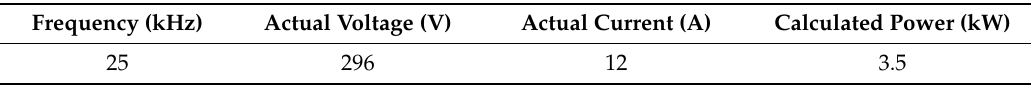
Table 1. Plasma coating settings for TEOS.